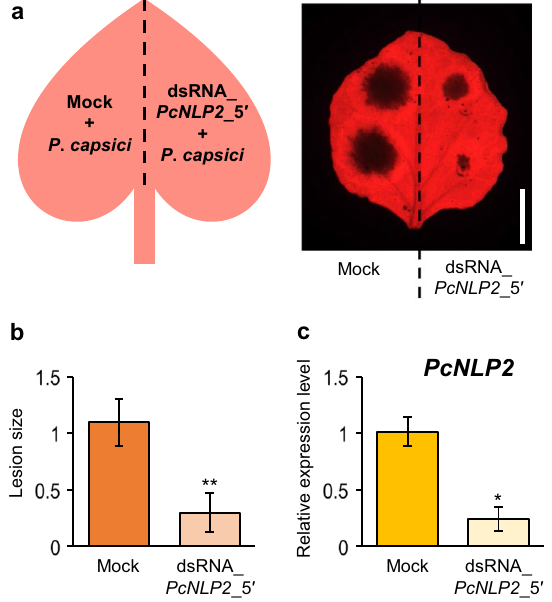
Fig. 2 Suppression of Phytophthora capsici infection and PcNLP2 expression via PcNLP2 -targeting dsRNA. a The left figure shows the scheme of dsRNA treatment and P . capsici infection, and the right figure shows the phenotype result of P . capsici infection after treatment with mock and dsRNA_ PcNLP2 _5 ′ , respectively, in 3 week-old Nicotiana benthamiana leaves using a fluorescence in vivo imaging system FOBI. Scale bar 1 cm. b Quantification of P . = capsici infection lesion size using ImageJ. c Quantification of PcNLP2 transcript level using quantitative real-time PCR (qRT-PCR). Mock: Treated with dsRNA targeting Renilla luciferase ; dsRNA_ PcNLP2 _5 ′ : Treated with dsRNA_ PcNLP2 _5 ′ . Data represent mean standard ± error of mean (SEM; N 3). Significance is determined by Student’s = t -test, * P < 0.05 and ** P < 0.01